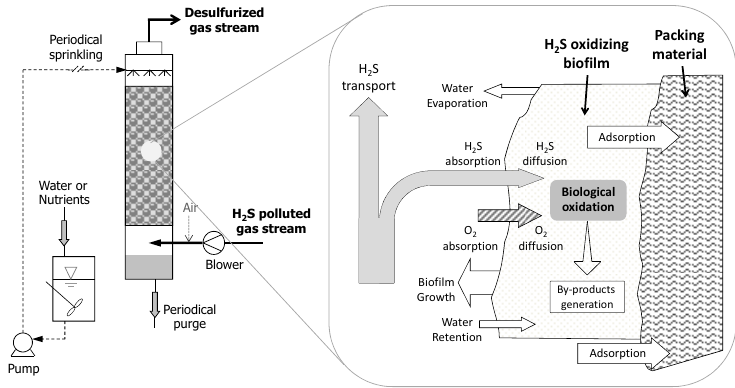
Figure 4. Schematic representation of the complex interactions that take place in biofilters.